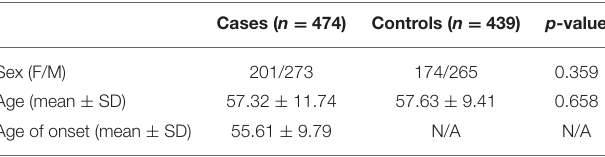
TABLE 1 | Demographic characteristics of patients with Parkinson’s disease (PD) and healthy